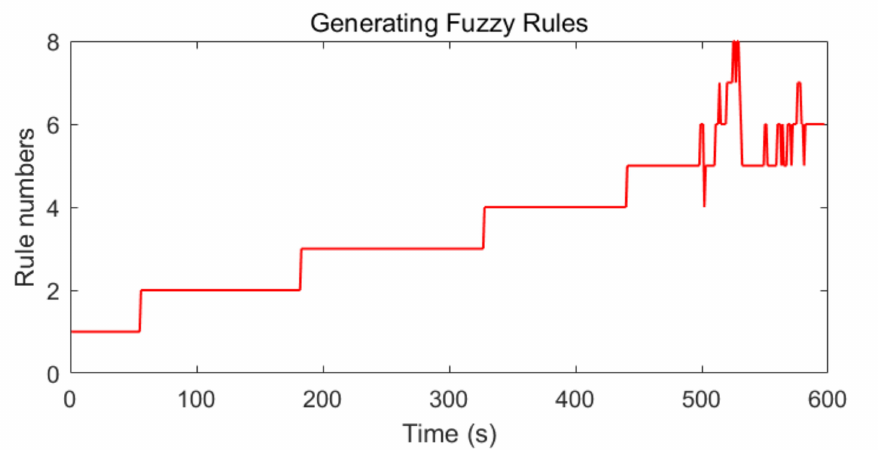
Figure 12. Generating fuzzy rules in